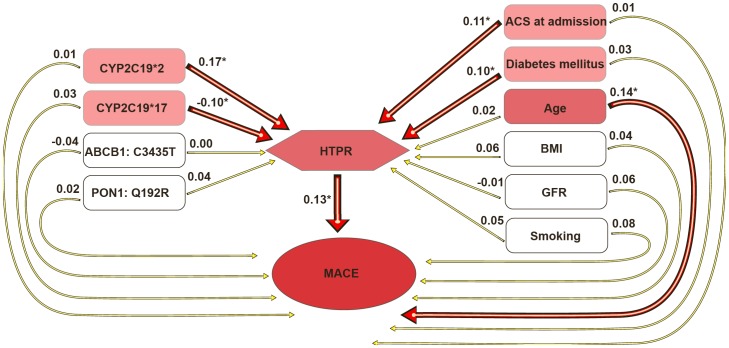
Path model of independent variables predicting high on treatment platelet reactivity (HTPR) and major adverse cardiac events (MACE: the composite of acute coronary syndrome, stent thrombosis and cardiac death).Paths from independent to dependent variables represent standardized estimates. *p<0.05; ACS: acute coronary syndrome; BMI: body mass index; GFR: glomerular filtration rate; CYP: cytochrome P450; ABCB1: gene encoding transmembrane transporter P-glycoprotein; PON1: paroxonase 1.